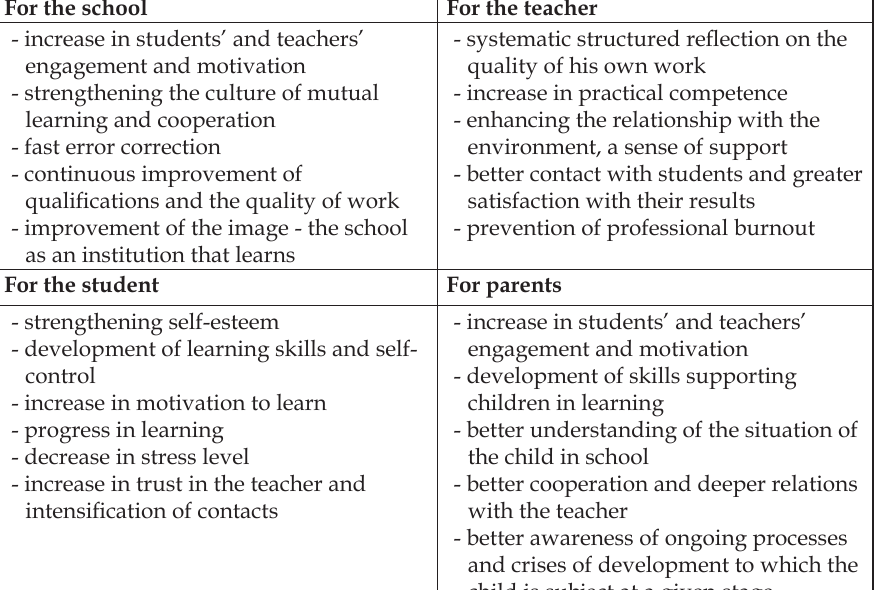
Table 1. Bene  ts of coaching For the